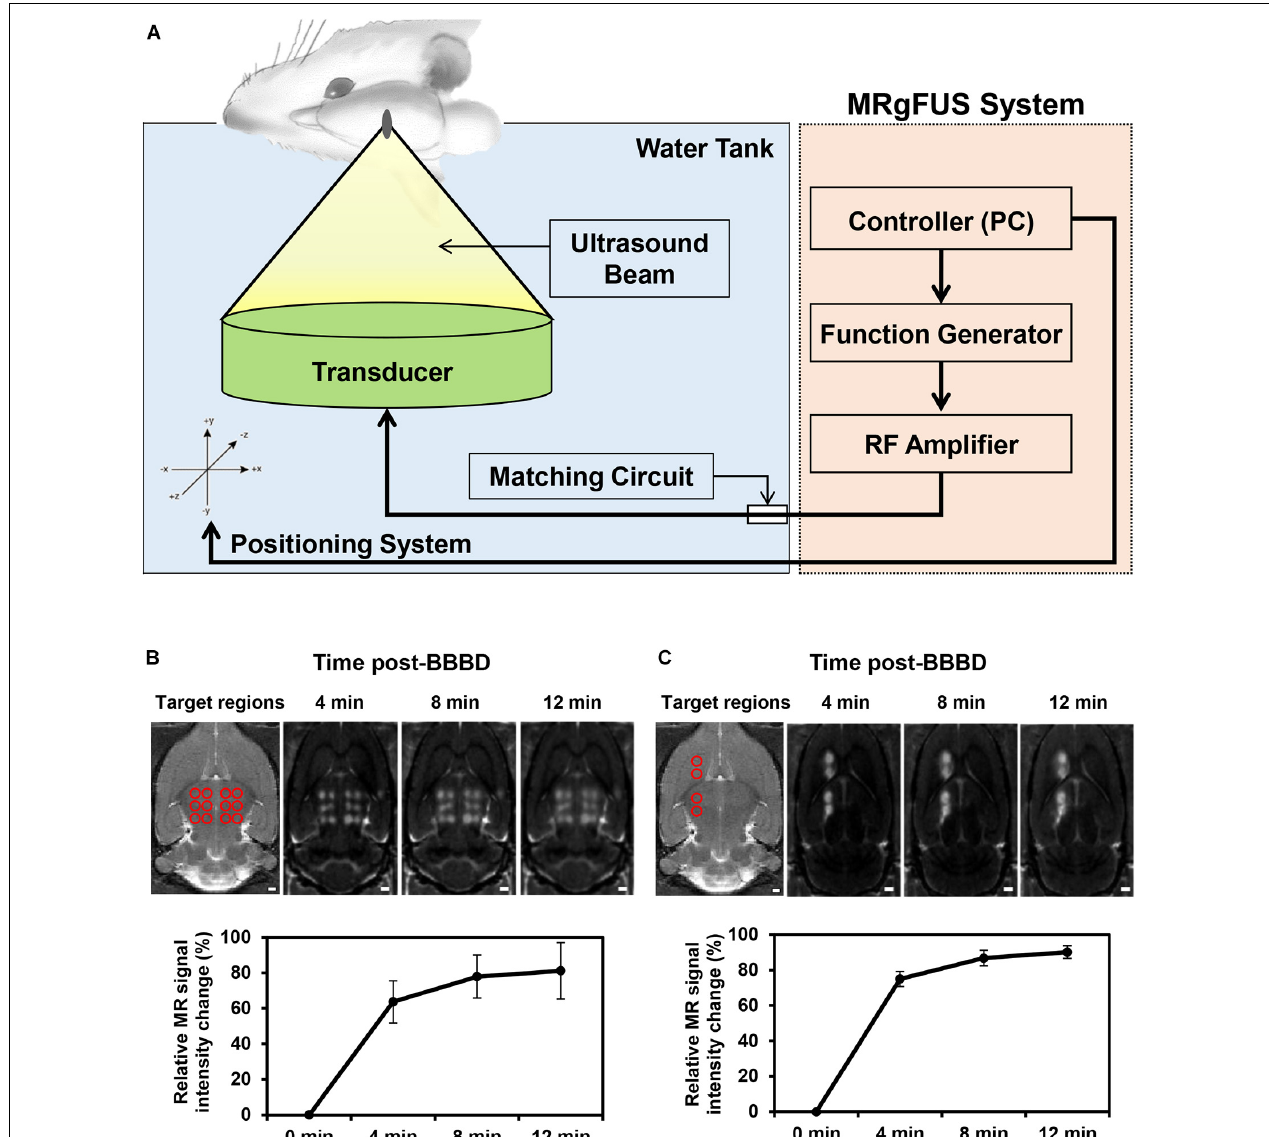
FIGURE 1 | Schematic of the MRgFUS system used for BBBD and changes of BBB permeability after BBBD. (A) Rats were placed in supine position and FUS waves generated upward to focal region in the brain. (B) To analyze the mRNA/protein expression level of P-gp, the 12 targeted points of the thalamus region were represented in a T2-weight MR image (top, left panel). Contrast-enhanced T1-weighted MR images were represented at three-time. The graph reflected mean intensity of contrast enhancement compare with pre-contrast T1-weighted MR images (bottom). (C) For immunohistochemistry analysis, T2-weighted MR Image of four targeted points was represented in caudate putamen and thalamus (top, left panel). Contrast-enhanced T1-weighted MR images reflected the increase in intensity according to continuous time. The relative signal intensity changes were obtained by Contrast-enhanced T1-weighted MRI